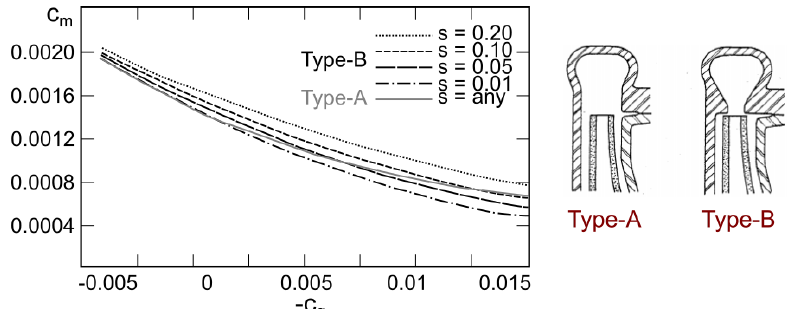
Figure 18. Type of the design and their torque coefficient. Reproduced from [98], ( left ) and ( right